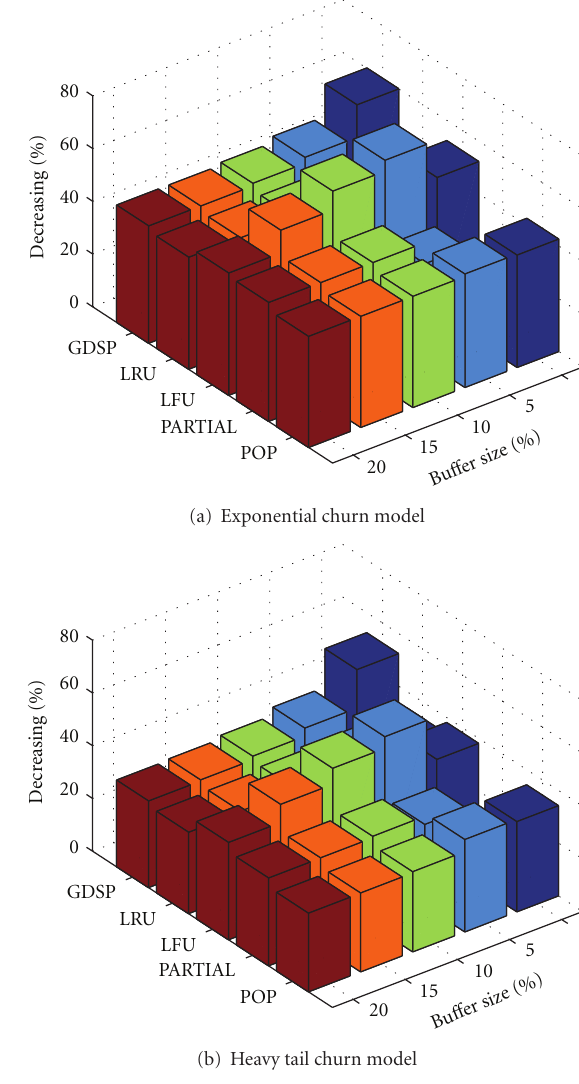
Figure 9: The amount of replicated data handled by policies. Figure 10: The decreasing on hit rate in a nonreplica system (see